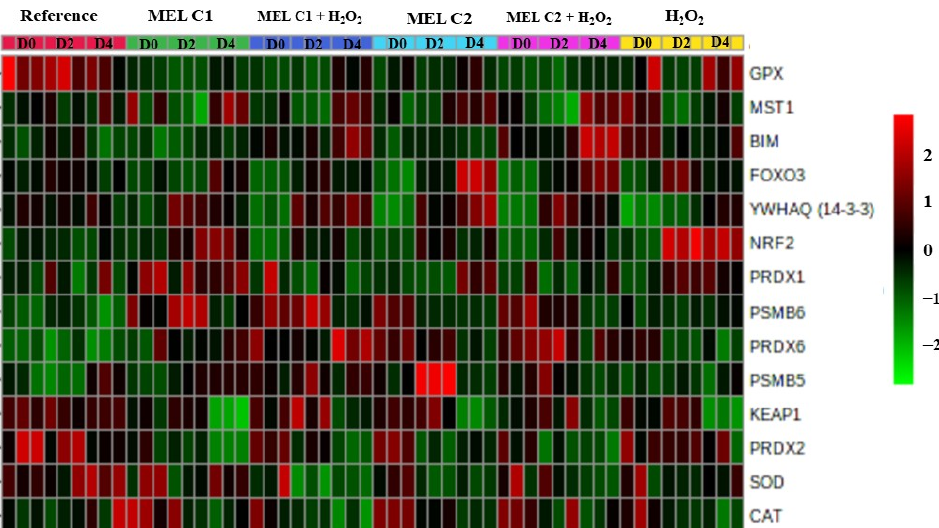
100 µ M H 2 O 2 . Test performed: GLM with 2-way ANOVA design, complemented by Bonferroni test.